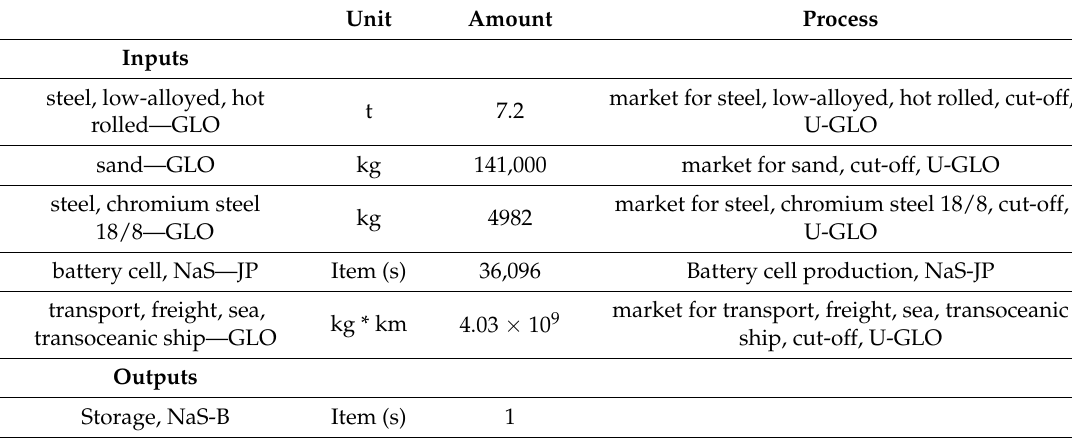
Table A28. Manufacturing Storage,